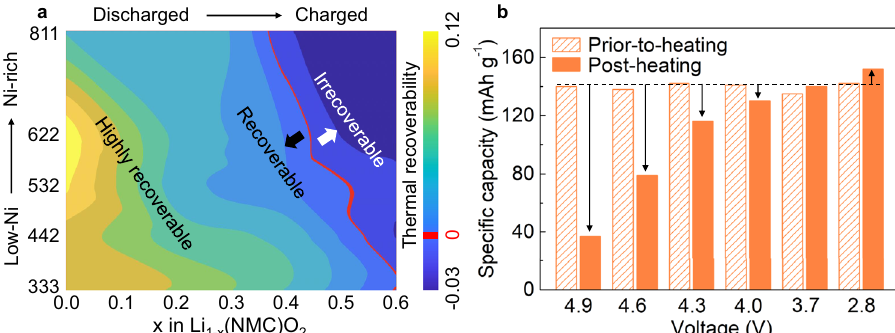
Fig. 1 Thermal recoverability of single-crystalline cathodes with different Ni and Li + concentrations. a Diagram showing the effect of Li concentration and NMC compositions on the thermal recoverability. The curved red line in the map annotates the zero-valued boundary. b Speci fi c capacity of the NMC622 electrode before and after thermal treatment at different stages. First, all the cells were cycled once with a 0.1 C (1 C = 180 mAh g − 1 ) rate at 2.8 – 4.9 V vs. Li + /Li. Then they were subjected to 10 cycles with a 1 C rate at 2.8 – 4.9 V to purposely induce lattice defects. After that, the cells were cycled once with a 0.1 C rate at 2.8 – 4.3 V vs. Li + /Li in order to quantify the prior-to-heating capacities. They are then charged to the targeted voltages (2.8, 3.7, 4.0, 4.3, 4.6, and 4.9 V) before being disassembled for the thermal treatment. After the thermal treatment, these electrodes were assembled back into coin cells and were cycled for 2 cycles with a 0.1 C rate at 2.8 – 4.3 V vs. Li + /Li in order to quantify the post-heating